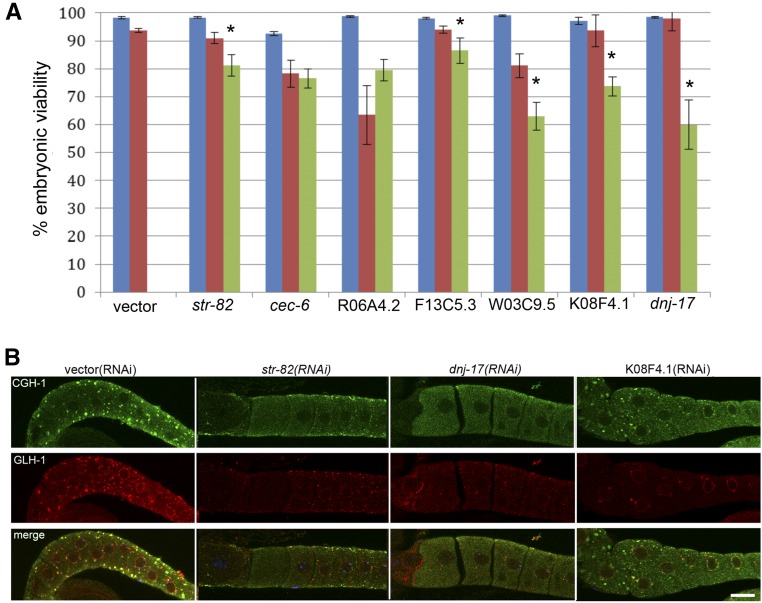
Disruption of RNP granule assembly correlates with decreased oocyte quality. (A) Blue bars show > 90% embryos are viable after RNAi of seven positive hits in wild-type worms, suggesting these genes are reasonable targets for analysis in arrested oocytes. For five of the seven genes, the percent of viable embryos significantly decreased when arrested oocytes did not assemble GFP::MEX-3 granules (green bars), as compared to worms where granules were detected (red bars). The percent embryonic viability is plotted as mean ± SEM; * P < 0.05 by Fisher’s exact test or Chi-square test (for W03C9.5, K08F4.1, and dnj-17). A minimum of 254 oocytes from a minimum of 11 females were analyzed for each RNAi target. (B) CGH-1 and GLH-1 fail to assemble into cortical granules after RNAi of a subset of the five genes. Note CGH-1 granules (green) are detected after RNAi of K08F4.1, but not str-82 or dnj-17. Large GLH-1 granules (red) are not detected after RNAi of any of the three genes shown. Quantitative data for all five genes are summarized in Table S2. GFP, Green fluorescent protein; RNAi, RNA interference; RNP, ribonucleoprotein.